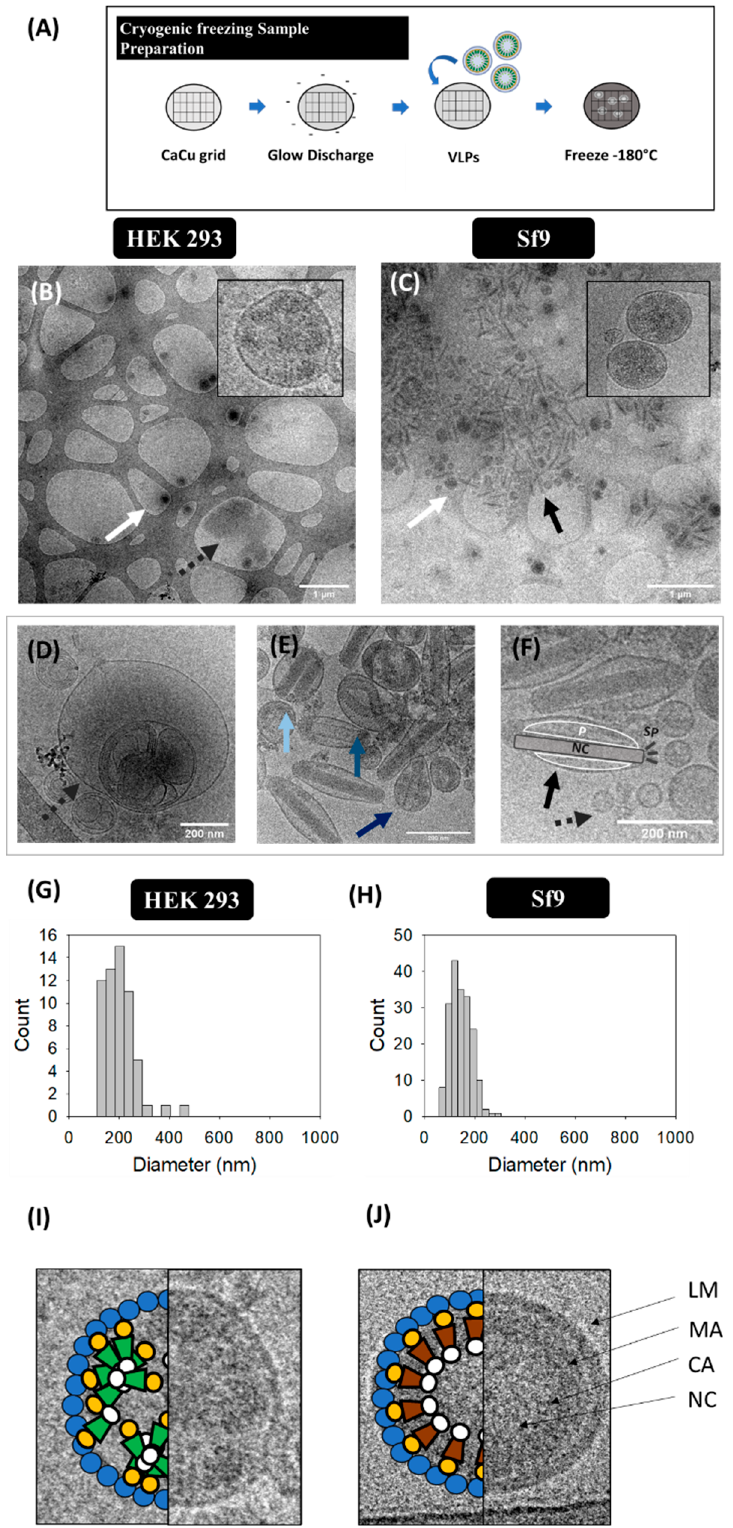
Figure 3. Cryo-TEM analysis of HIV-1 Gag-eGFP VLPs produced in HEK 293 and Sf9 cells harvested at 72 hpt and 72 hpi, respectively. ( A ) Sample preparation protocol. Supernatant from HEK 293 ( B ) and Sf9 cells ( C ). Both samples were prepared and visualized in Holey carbon grids. ( D – F ) Morphological characterization of contaminant particles including multivesicular bodies (MVB) ( D ), occlusion-derived BV (ODV, light blue), a relaxed-form of the BV (rBV, mid blue) or BV-containing vesicles or protein structures (cBV, dark blue) ( E ), and analysis of the infective BV (budded virus) structure: nucleocapsid (NC), lateral pocket side (P) and apical spikes (SP) ( F ). ( G – H ) PSD analysis of